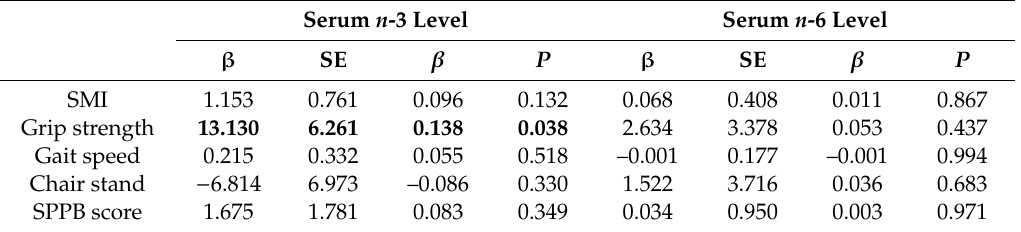
Table 3. Linear regression analyses to determine the association of serum levels of n -3 and n -6 fatty acids with sarcopenia